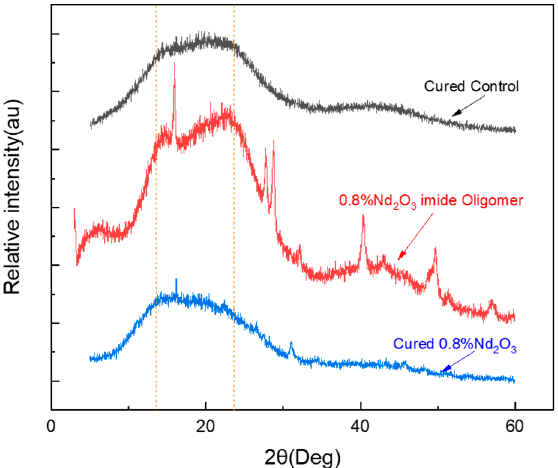
Figure 12. The SEM patterns of the resin section after isothermal aging at 350 °C for 450 h: ( a ) control and ( b ) 0.8 wt% Nd 2 O 3 . and ( b ) 0.8 wt% Nd 2 O 3 .